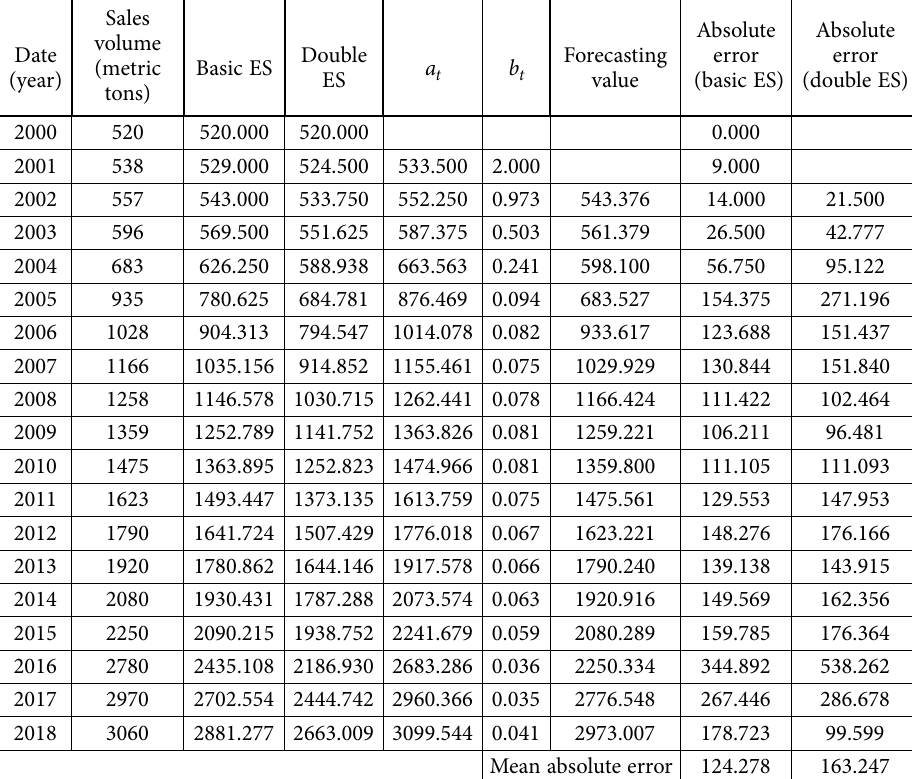
Table 2. Basic ES and double ES of the sales